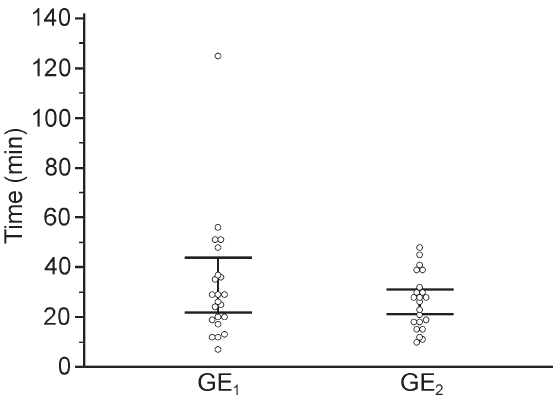
Figure 1. Median gastric t 1/2 emptying values determined by scintigraphic studies. GE 1 corresponds to the study done before the removal of fecal impaction and GE 2 corresponds to the study done after the patient achieved regular bowel movements. The top horizontal line indicates the 75% quartile and the bottom line indicates the 25% quartile. The number of patients in each group was 22. No statistically significant differences were found between the median values (GE 1 = 27.0; GE 2 = 27.5) (Wilcoxon signed rank test, P =